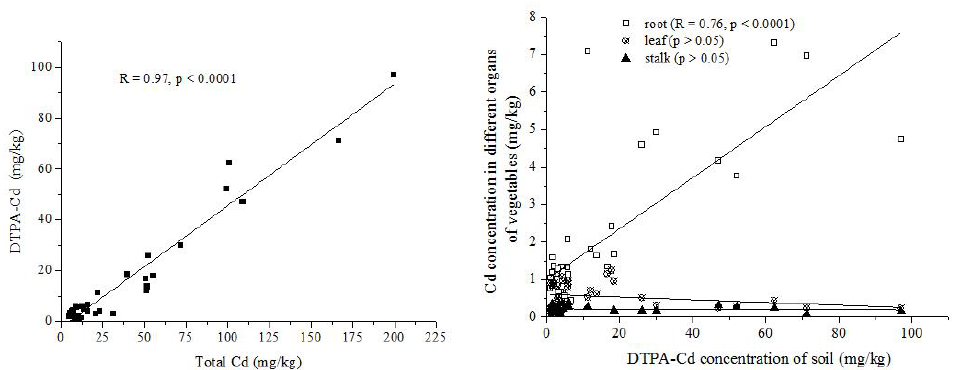
Figure 6. Correlations between DTPA-extracted Cd concentrations in soil (DW) and total Cd concentrations in soil (DW) and in different tissues of vegetables (DW).